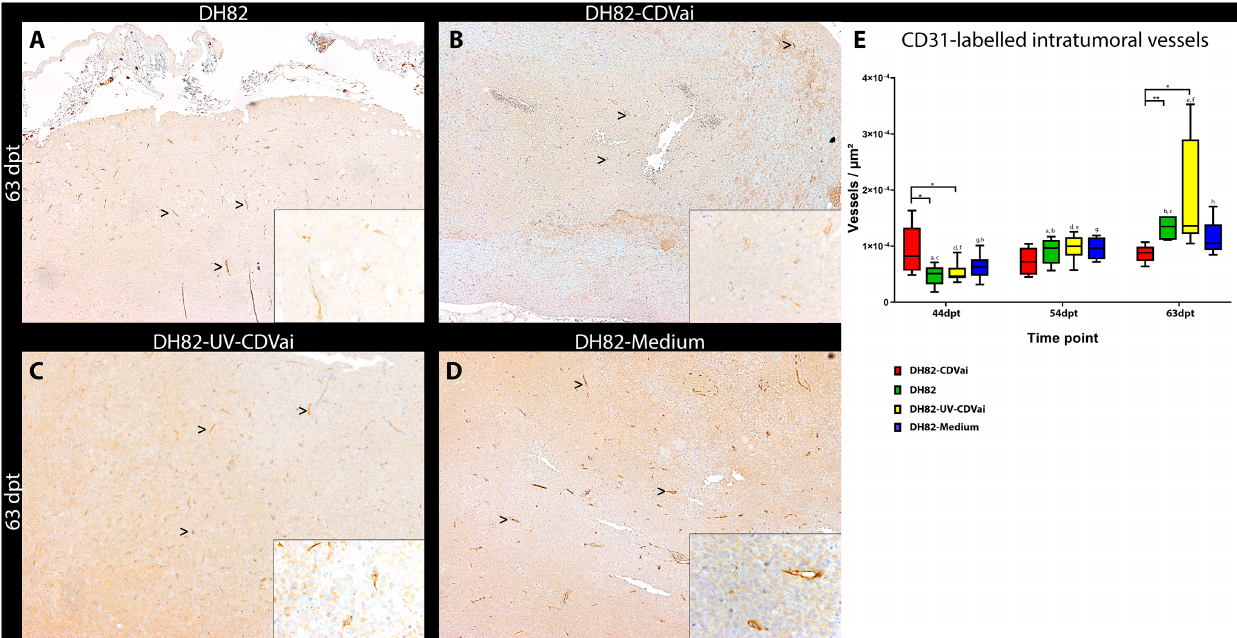
Figure 10. CD31 immunolabeling in murine subcutaneous DH82 cell xenografts for assessment of microvessel density. All CD31-expressing structures with a definable lumen were counted as vessels (arrowheads). ( A ) displays non-infected (DH82), ( B ) intratumorally canine distemper virus (CDV)-infected (DH82-CDVai), ( C ) intratumorally UV-inactivated CDV-injected (DH82-UV-CDVai) and ( D ) intratumorally medium-injected (DH82-medium) neoplasms at 63 days post-transplantation (dpt). ( E ) shows a graphical overview of the microvessel density within the different groups. All graphs represent Box and whisker plots with statistically significant differences between different groups at the same time point (* p < 0.05 and ** p ≤ 0.01) and between different time points within the same group (a–h; p < 0.05). Scale bar = 100 µ m and scale bar—insert = 20 µ